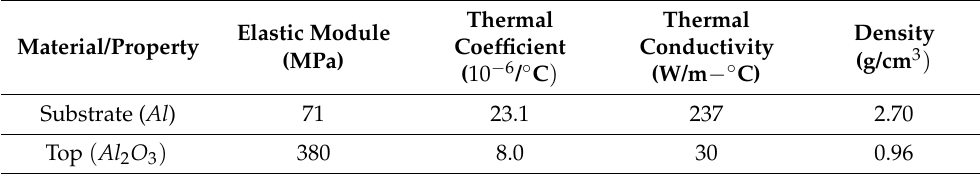
Table 1. Mechanical and thermal properties used for analyzing thermo-elastic characteristics of rotating FGM circular